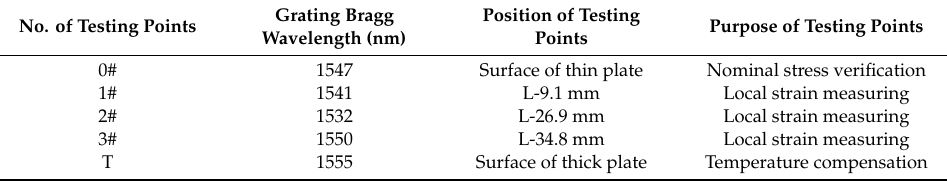
Figure 7. Schematic diagram of FBG arrangement. Table 4. Description of testing